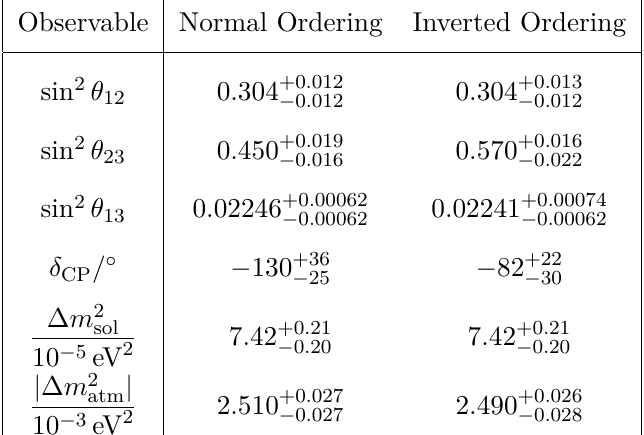
≡ m 2 − m 2 2 1 sol